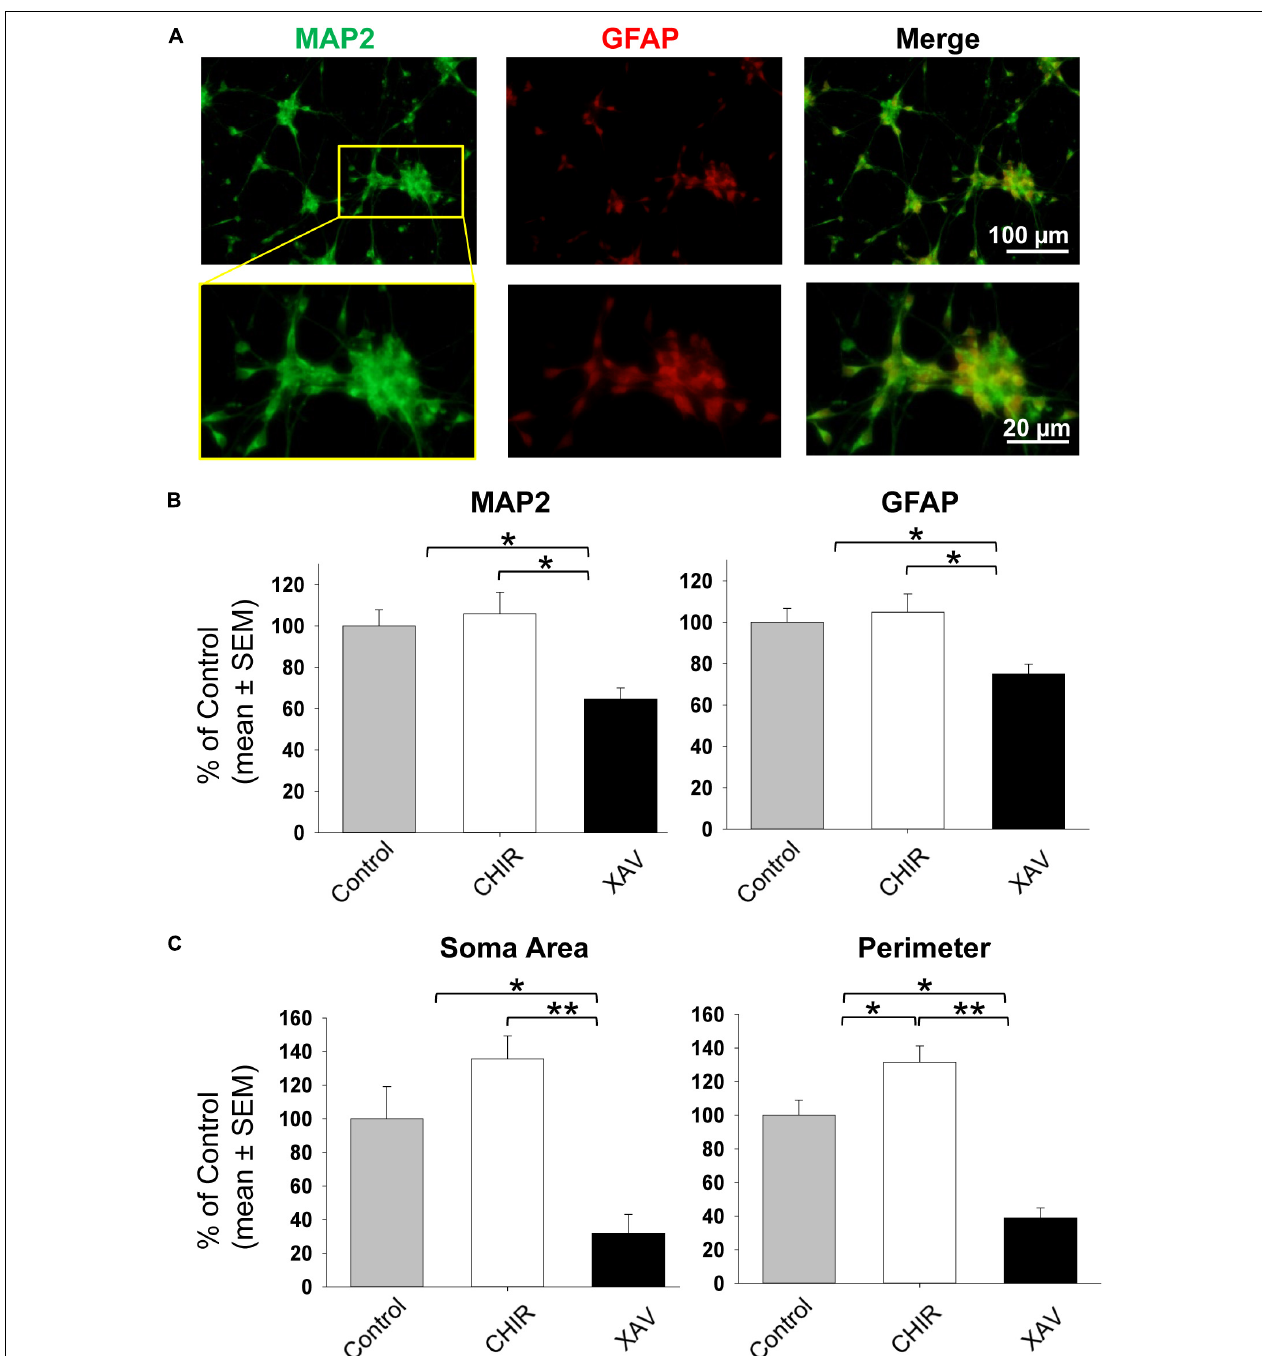
FIGURE 4 | Neuronal differentiation of hNPCs treated with Wnt modulators. (A) Representative images of fixed hNPCs-derived neurons after 30 days of neuronal differentiation, immunostained for MAP2 (green) and GFAP (red). Top row: full field of view. Bottom row: enhanced detail of a seeded neurosphere with MAP2 and GFAP positive cells protruding outward. Neuronal differentiation was induced by detaching hNPCs and re-seeding neurosphere onto poly- D -lysine/laminin coated glass coverslips. Cells were grown in neural differentiation medium (NDM) including BDNF, GDNF, and NT-3 (see “Materials and Methods” section). (B) Quantification of MAP2 and GFAP immunostaining as shown in panel (A) , following 30 days on neuronal differentiation in control conditions (gray bars), or under treatment with 3 µ M CHIR (white bars) or XAV (black bars). Experiments were repeated three times in all 4 hNPC lines. Values are shown as mean ± SEM, relative to control. * p < 0.05, ANOVA. (C) Morphological assessment of neuronal differentiation (see also Figures 2B,C ). The soma area ( left ) and the perimeter ( right ) of living cells was quantified in control conditions (gray bars), or after treatment with 3 µ M CHIR (white bars) or XAV (black bars). Experiments were repeated three times in all 4 hNPC lines, 3 random fields were imaged in each experiment, > 50 cells were analyzed in each field. Values are shown as mean ± SEM, relative to control. * p < 0.05; ** p < 0.01, ANOVA.